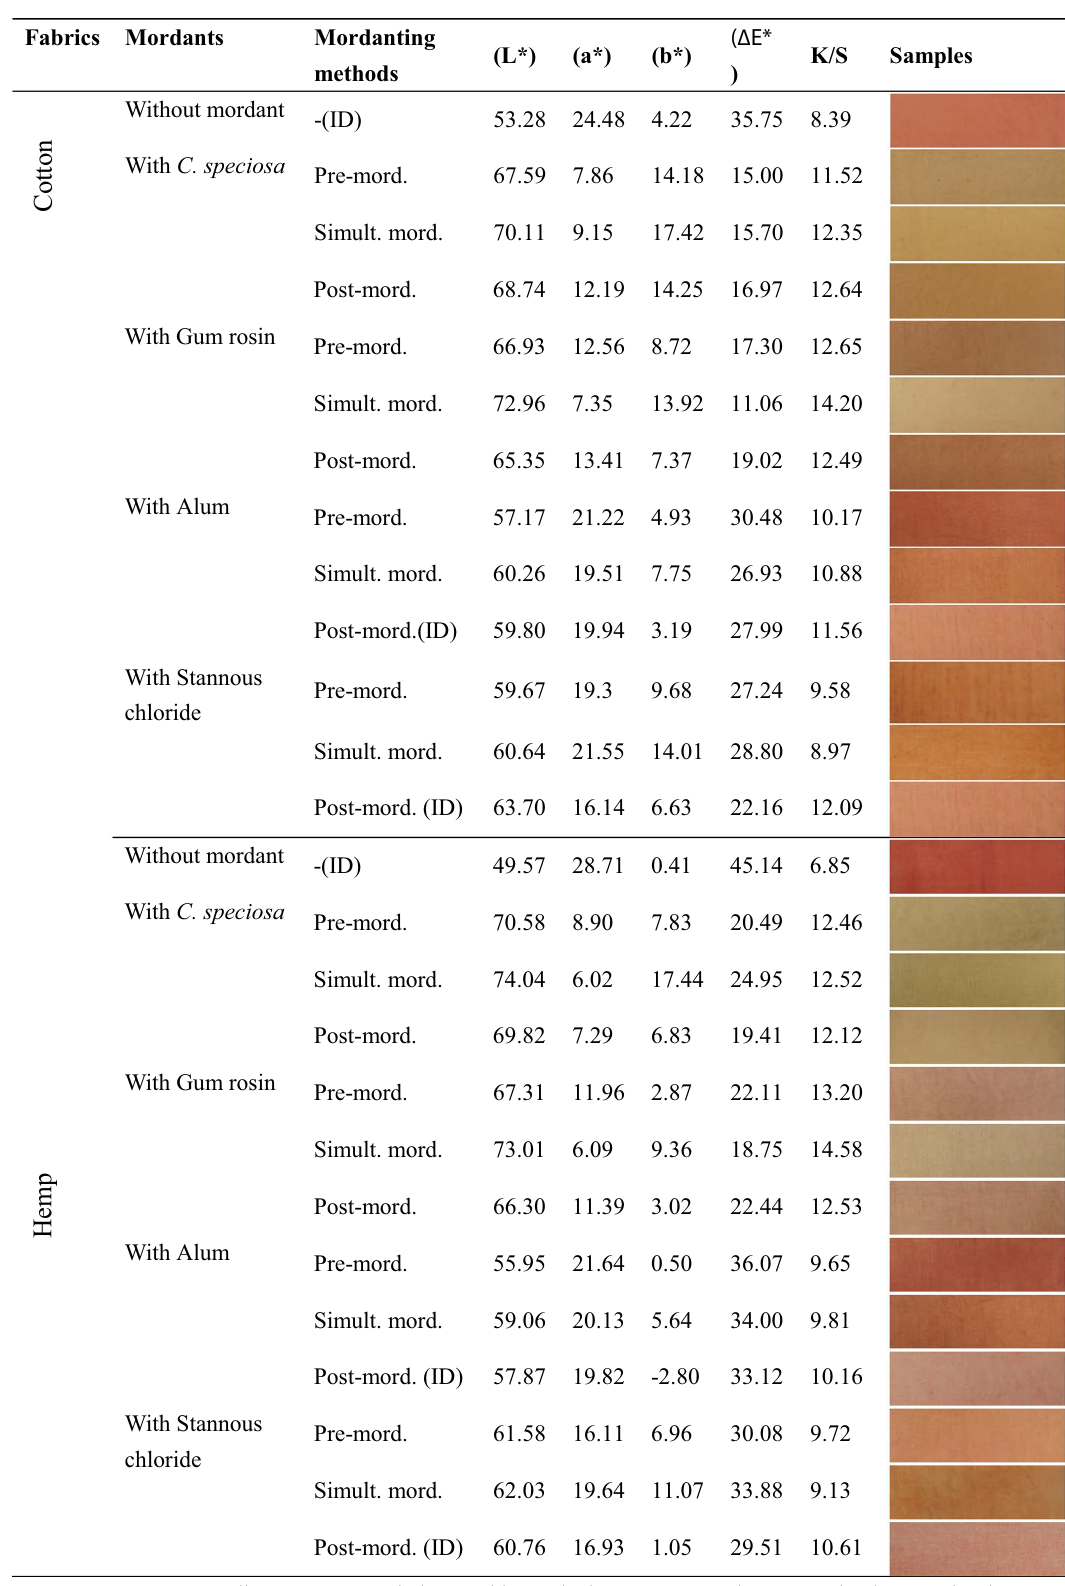
Table 4. K/S values and colorimetric data of recycled madder dyed fabrics with and without mordanting. ID, Indigenous recycled madder dyeing; Pre-mord, Pre-mordanting; Simult. mord., Simultaneous mordanting; Post-mord, Post